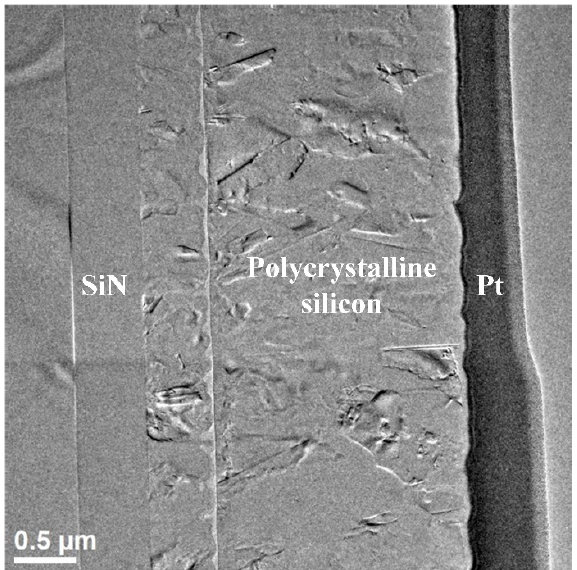
Figure 3. Low resolution TEM photograph of the specimen. SiN, polycrystalline silicon, and platinum can be observed.